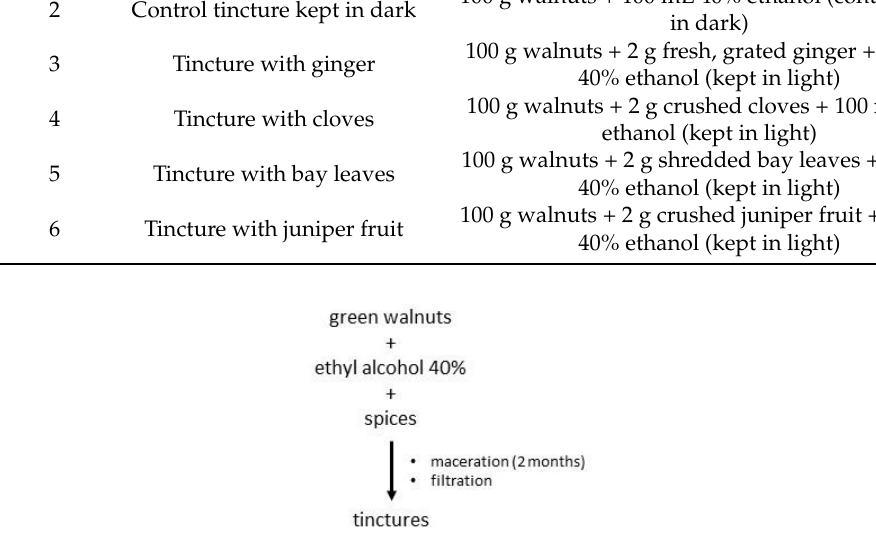
Table 1. The composition of the prepared tinctures.